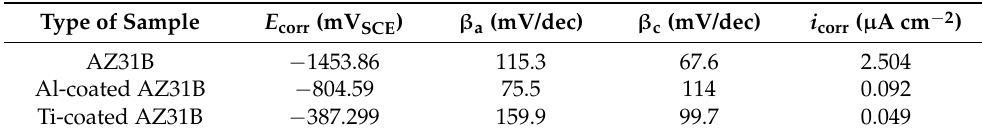
Table 3. The E corr , and i corr , β a and β c for bare and coated samples calculated from the forward scan of cyclic potentiodynamic polarization (CPP)